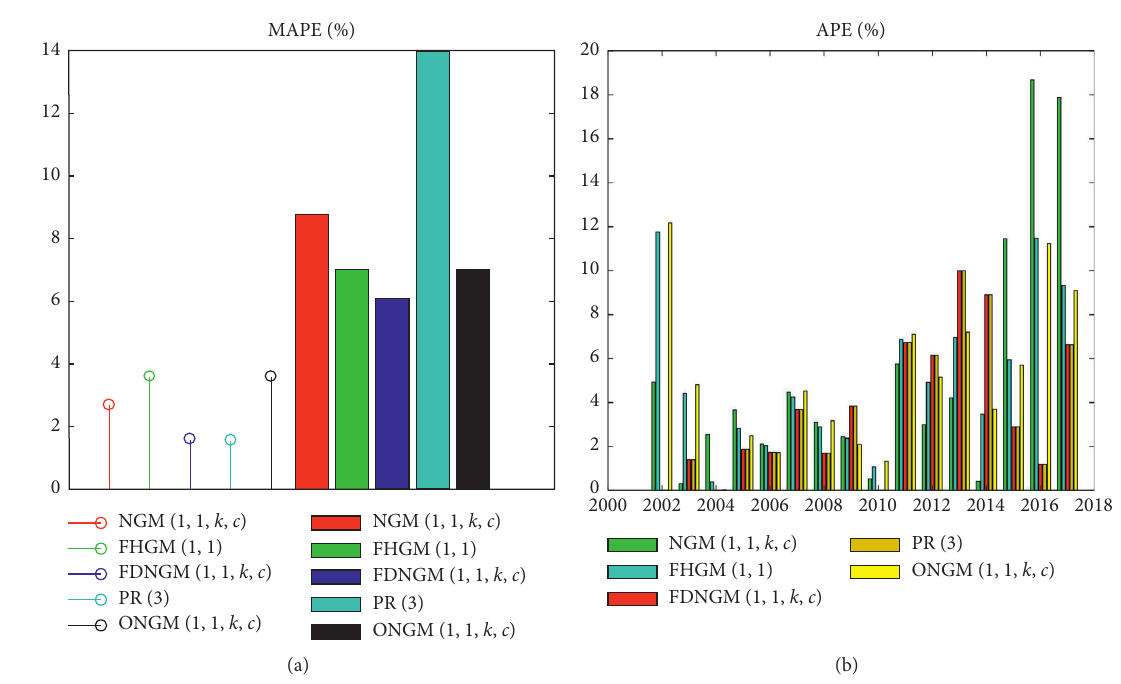
Figure 5: APEs and MAPEs of the competitive models in Case